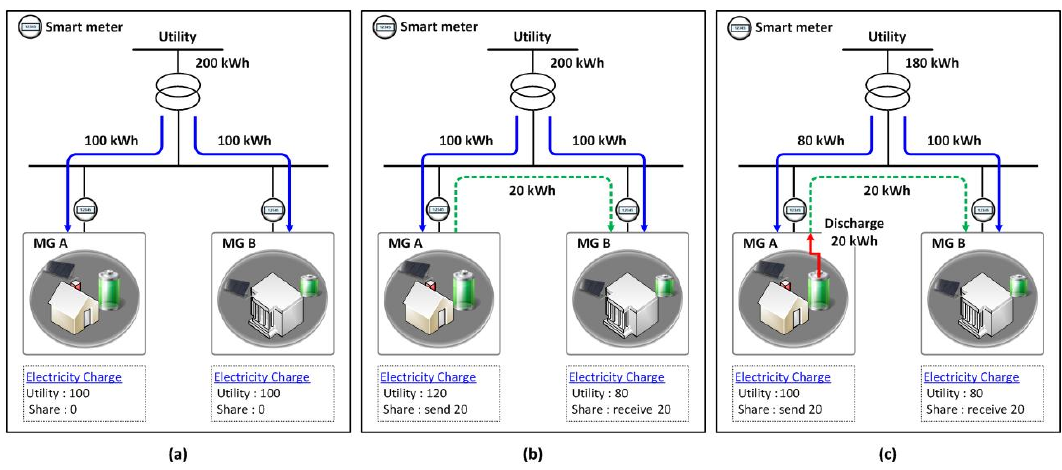
Figure 2. Power flow and billing information of the two power sharing schemes: ( a ) without power sharing; ( b ) power sharing without physical control of resources; ( c ) power sharing with physical control of resources.